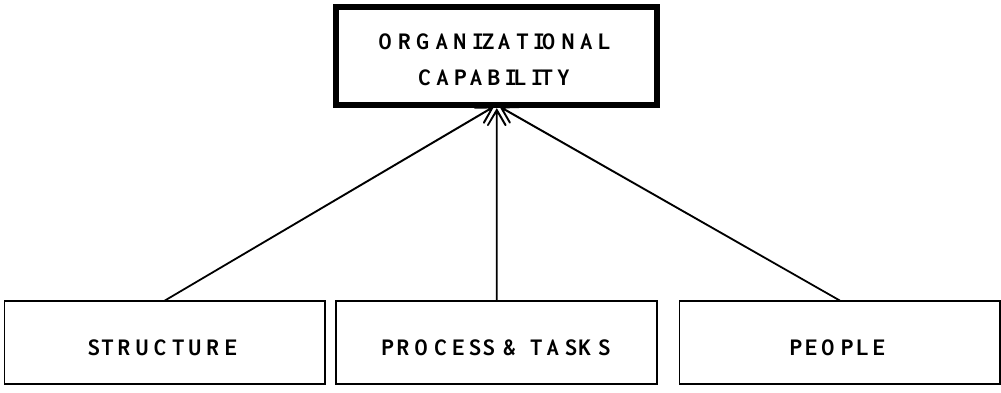
Figure 1: The Main Elements of a Dynamic Organizational